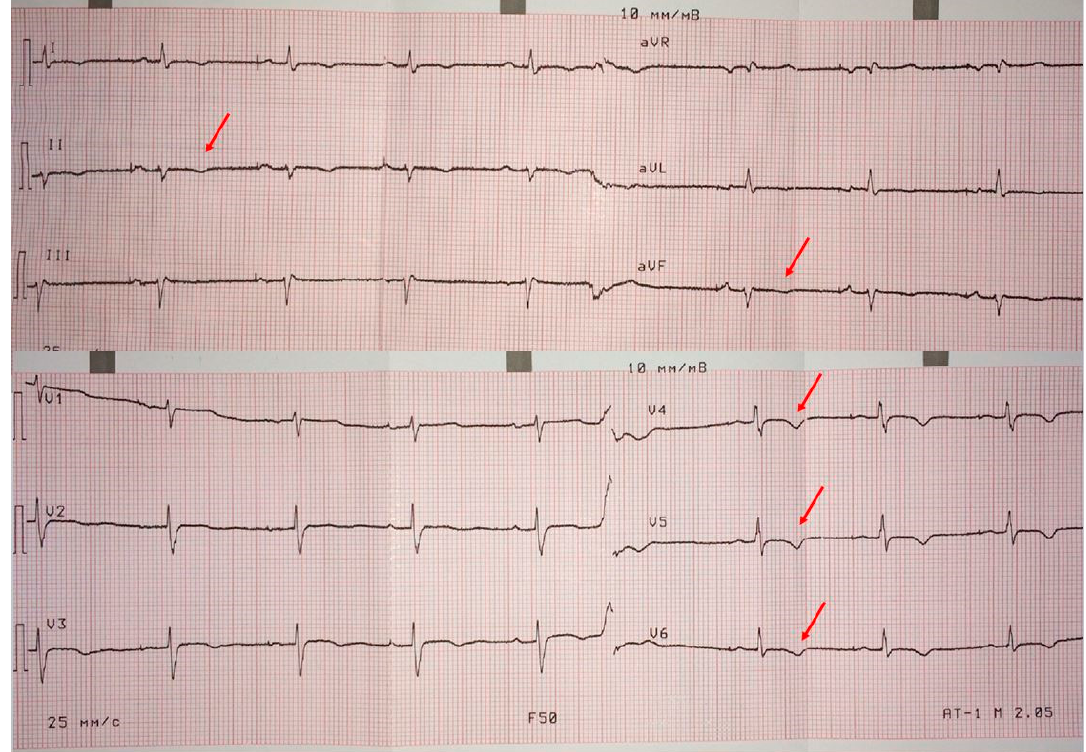
Figure 2. Patient’s ECG. Low QRS voltages in limb leads, negative T wave in left precordial leads (minor ARVC criterion) and in inferior leads.